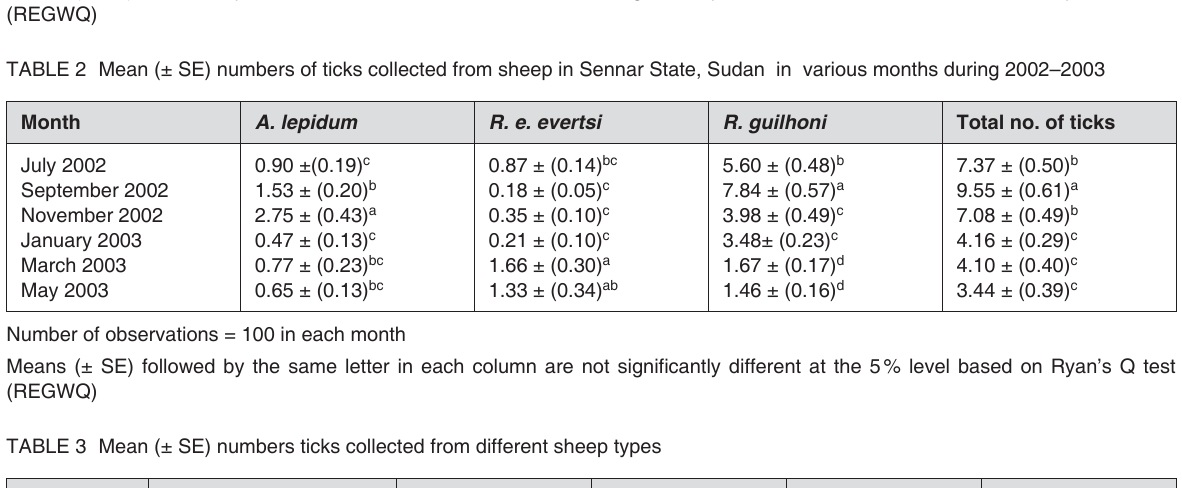
Number of observations = 120 at each